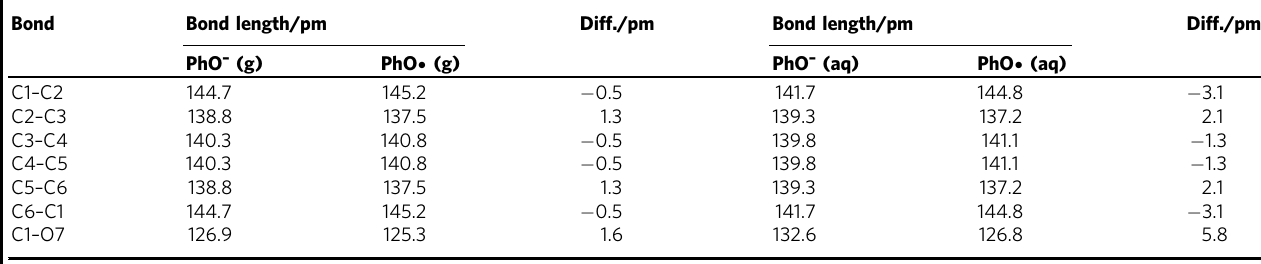
Table 2 Calculated bond lengths of the phenoxide ion and the phenoxyl radical in both gas phase and aqueous solution